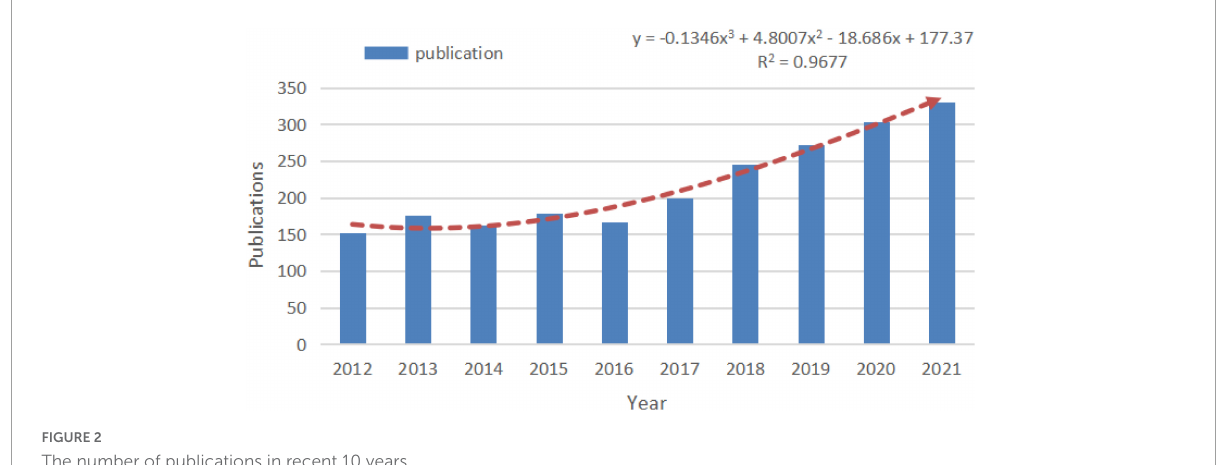
FIGURE2 The number of publications in recent 10 years.